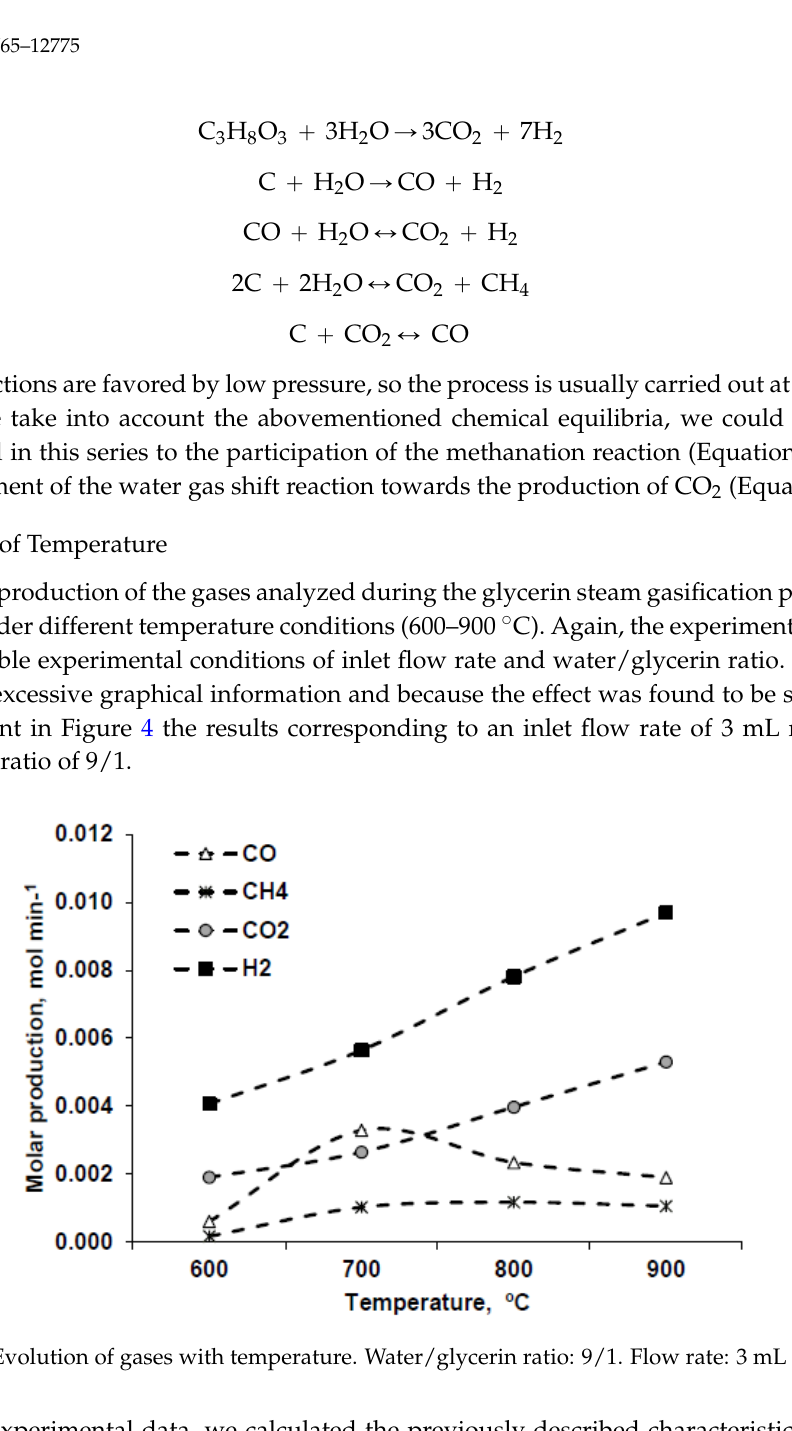
Figure 4. Evolution of gases with temperature. Water/glycerin ratio: 9/1. Flow rate: 3 mL min − 1 .